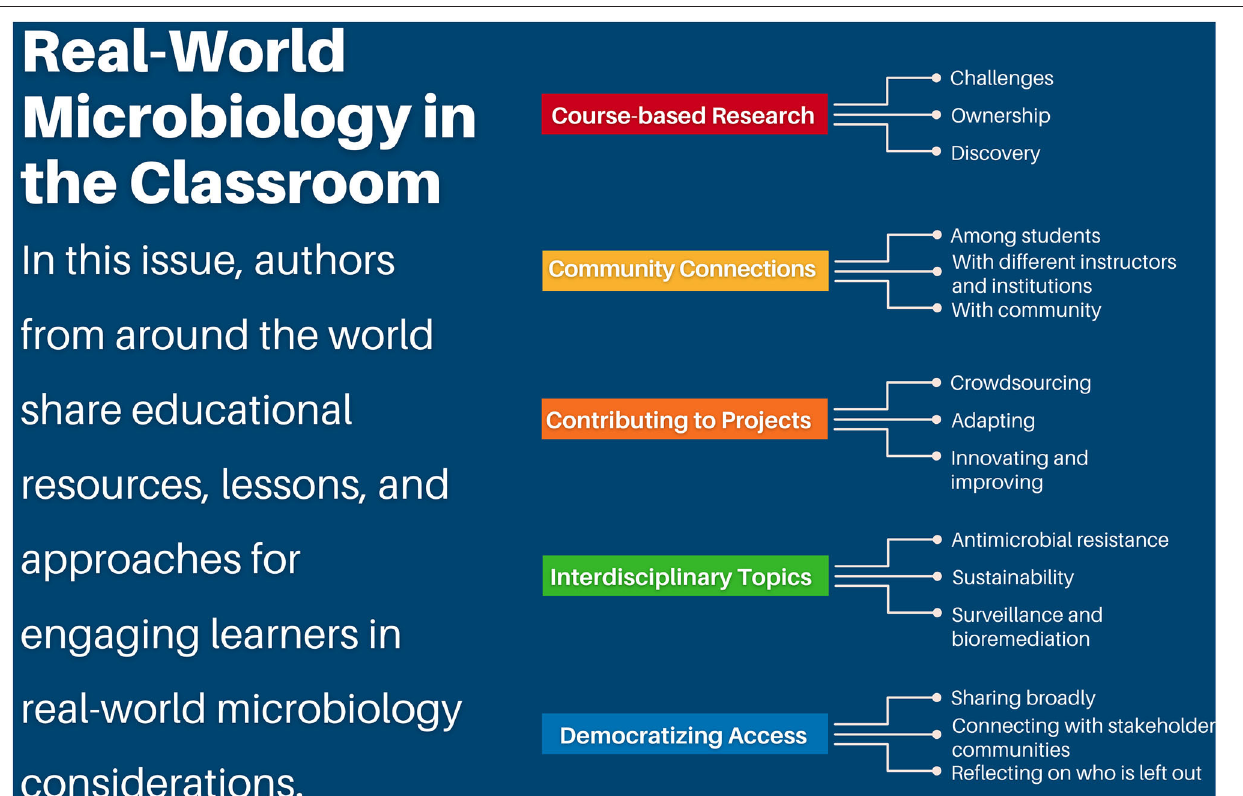
FIGURE 1 | Real-world microbiology in the classroom. In this issue, authors from around the world share educational resources, lessons, and approaches for engaging learners in real-world microbiology considerations. Course-based research experiences challenge learners, foster ownership of projects, and inspire discovery. Community connections can be fostered among students, with different institutions and instructors, and with the community. Participants and educators can contribute to projects through crowdsourcing, adapting resources and projects, and innovating and improving the student experience and research methodologies. Interdisciplinary topics in this issue include antimicrobial resistance, sustainability, and surveillance and bioremediation using microorganisms. With the vision of democratizing access, educators and students can share broadly, connect with stakeholder communities, and reflect on who is left